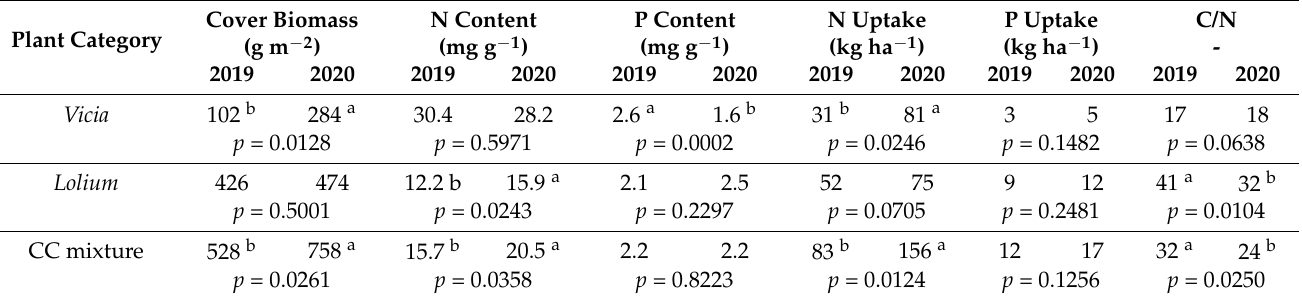
Table 2. Above-ground biomass (g m − 2 ), N (mg g − 1 ) and P (mg g − 1 ) content, total N and P uptake (kg ha − 1 ) and C/N ratio for the two CC genera and for the CC mixture. Different letters are significantly different at p < 0.05 (Duncan test). Cover Biomass N Content P Content N Uptake P Plant Category